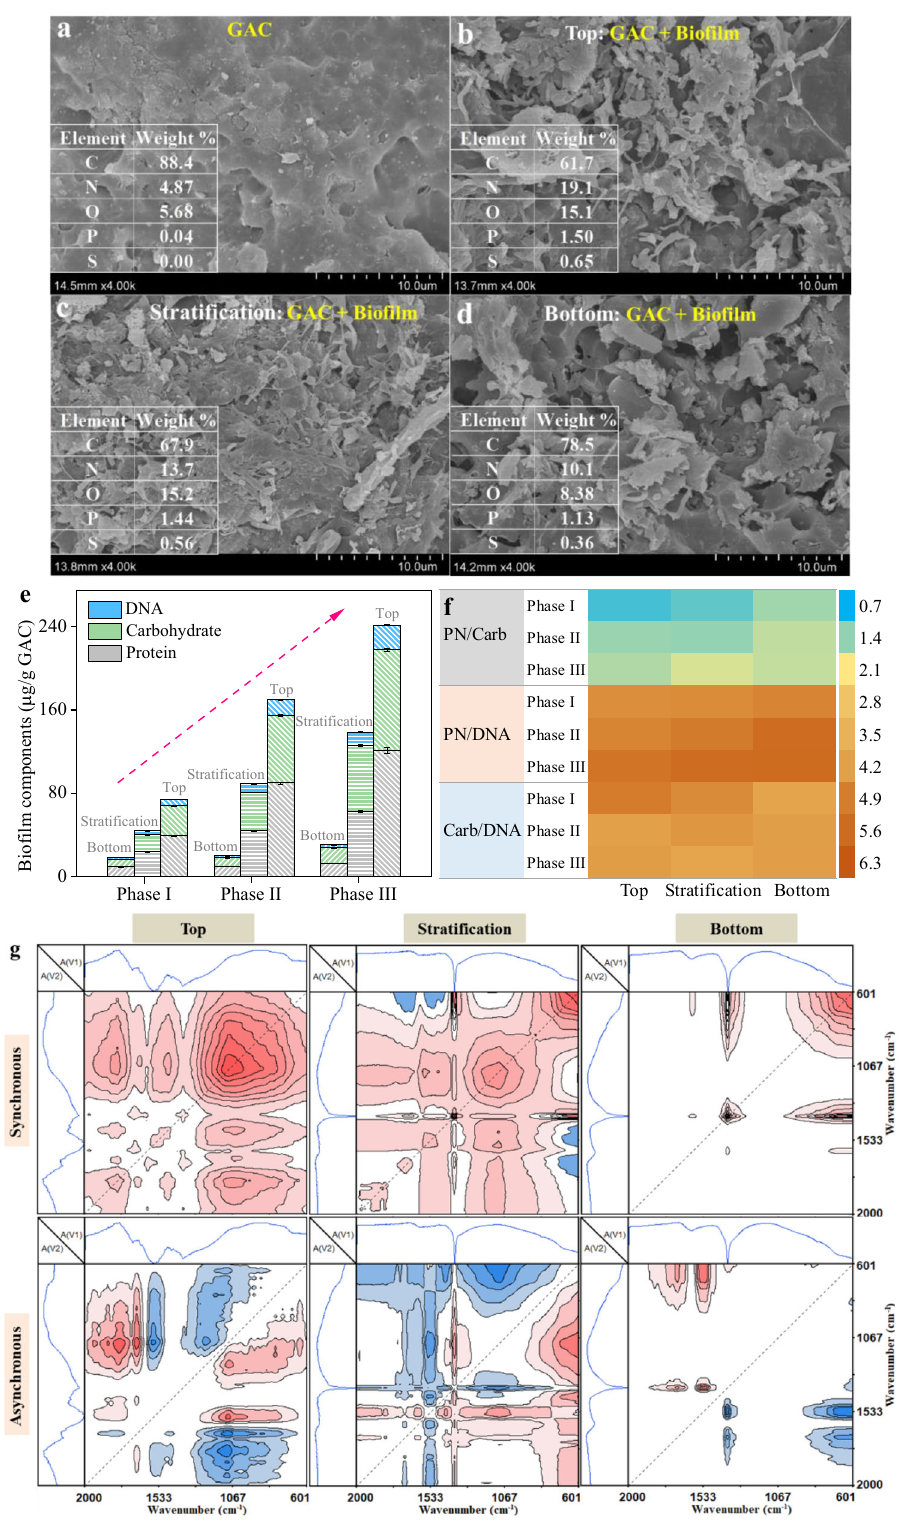
Fig. 1 Bio fi lm characteristics. Dynamics of bio fi lm characteristics represented by a – d the surface morphology and the element sidtribution of the granular-activated carbon and bio fi lm using scanning electron microscope (SEM) combined with energy dispersive X-ray (EDX) spectrometry, e bio fi lm components containing protein, carbohydrate and DNA and f component ratios, and g the two dimension (2D)-FTIR correlation synchronous and asynchronous maps generated from 600 – 2000 cm − 1 region of the bio fi lms at the noted reactor position and operation Phase. Red represents positive correlations and blue represents negative correlations; higher color intensity indicates a stronger positive or negative correlation. Phases I, II, and III represent the saturated/unsaturated ratio of 1:2.3, 1:1.1, and 1:0.5,